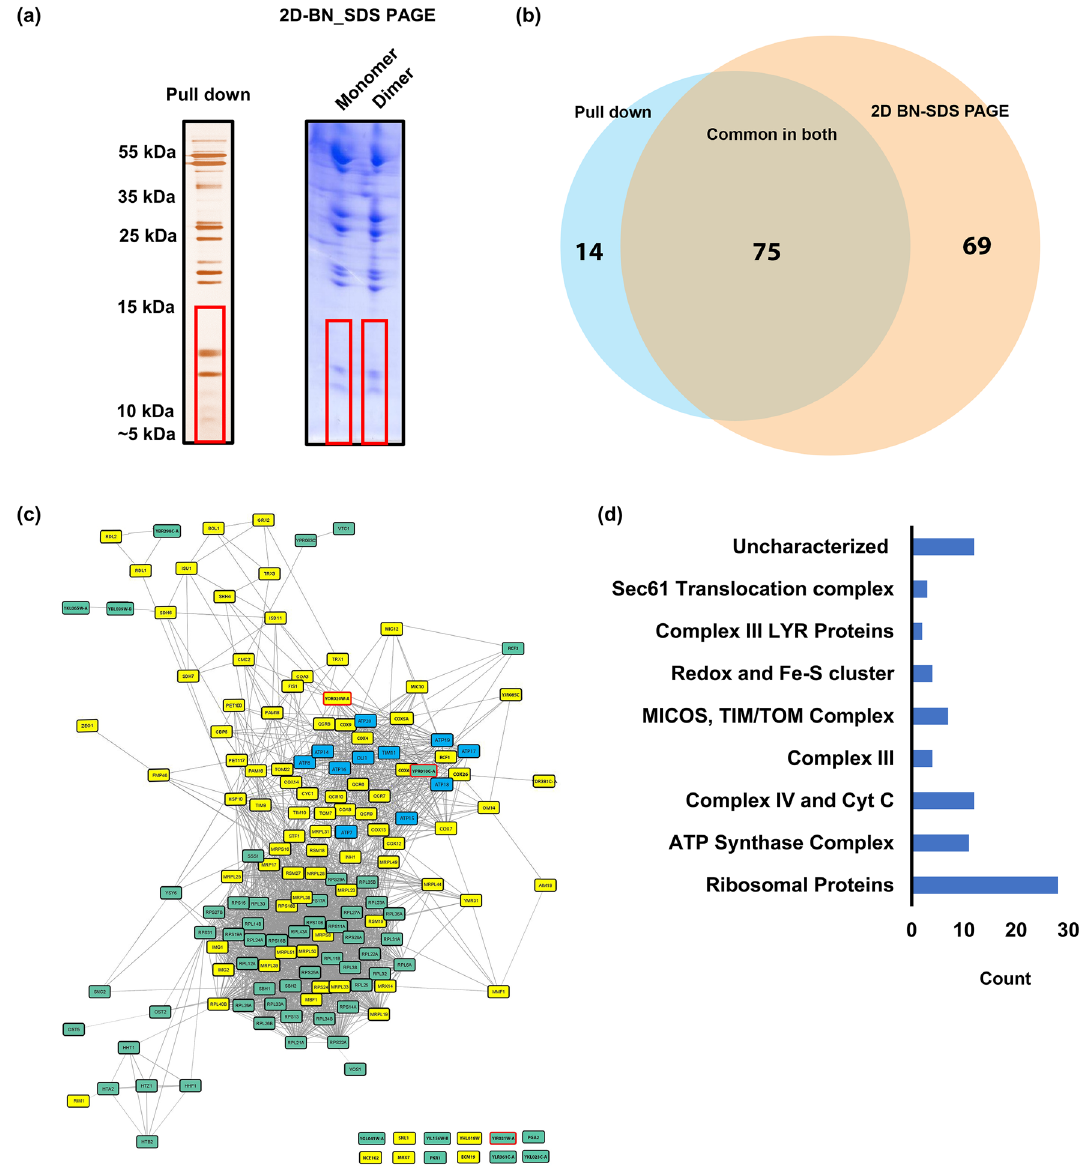
Figure 1. Small molecule interactome of S. cerevisiae ATP synthase. ( a ) Pulldown of ATP synthase complex by HA-6His-tagged Atp6 or the monomers and dimers of ATP synthase extracted by digitonin and separated in two-dimensional BN-SDS-PAGE gel and visualized by silver stain (left panel) or Coomassie (right panel). Gel pieces from region indicated by red frames were cut-off for LC/MS analysis. The experiments were performed many times and representative gels are shown. Original blots/gels are presented in SupplementaryRowImages pages 9 and 10. ( b ) Venn diagram of the ≤ 20 kDa proteins associated with ATP synthase identified in the interactome analysis from the two different approaches. ( c ) High confidence ATP synthase interactors identified by MS were connected into a network using the STRING database and visualized using the STRING 106 plugin in Cytoscape. Proteins marked in yellow are known proteins that localize to the mitochondria. Proteins marked in blue are the known ATP synthase subunits identified in the analysis. Proteins marked in green were not previously assigned to be localized to mitochondria. Mco10, Min8 and Yir021w-a are indicated by red frames. ( d ) Classification of the identified proteins into known complexes and